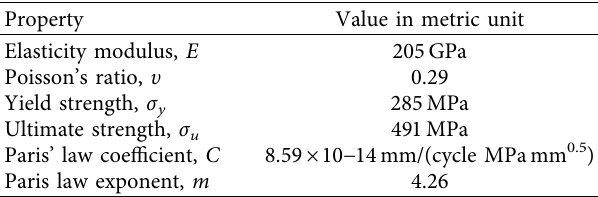
Figure 3: Geometrical details of the modified compact tension specimen (MCTS) (all dimensions in mm). Table 1: Properties of the considered